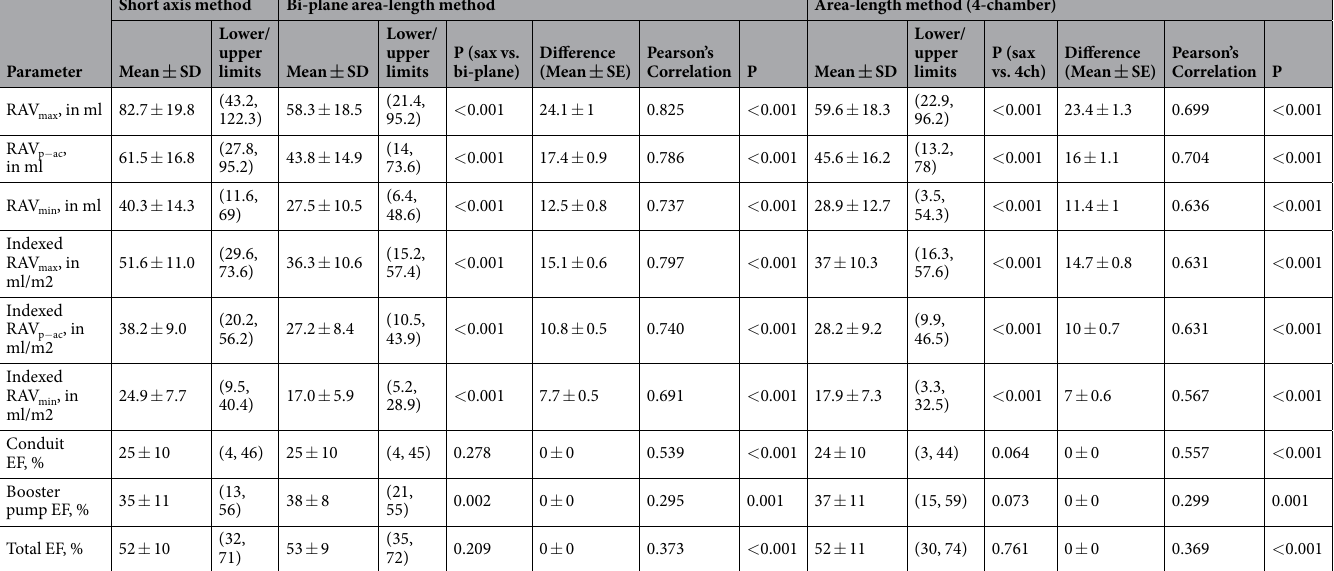
Table 6. Right atrial volume and phasic function parameters measured by the short axis or area-length method (n = 135). Lower/upper limits calculated as mean ± 2 SD; RAV max , maximal right atrial volume; RAV p − ac , right atrial volume prior to atrial contraction; RAV min , minimal right atrial volume; Indexed volumes are calculated by corresponding volume in ml divided by BSA in m 2 ; Conduit EF, Conduit right atrial